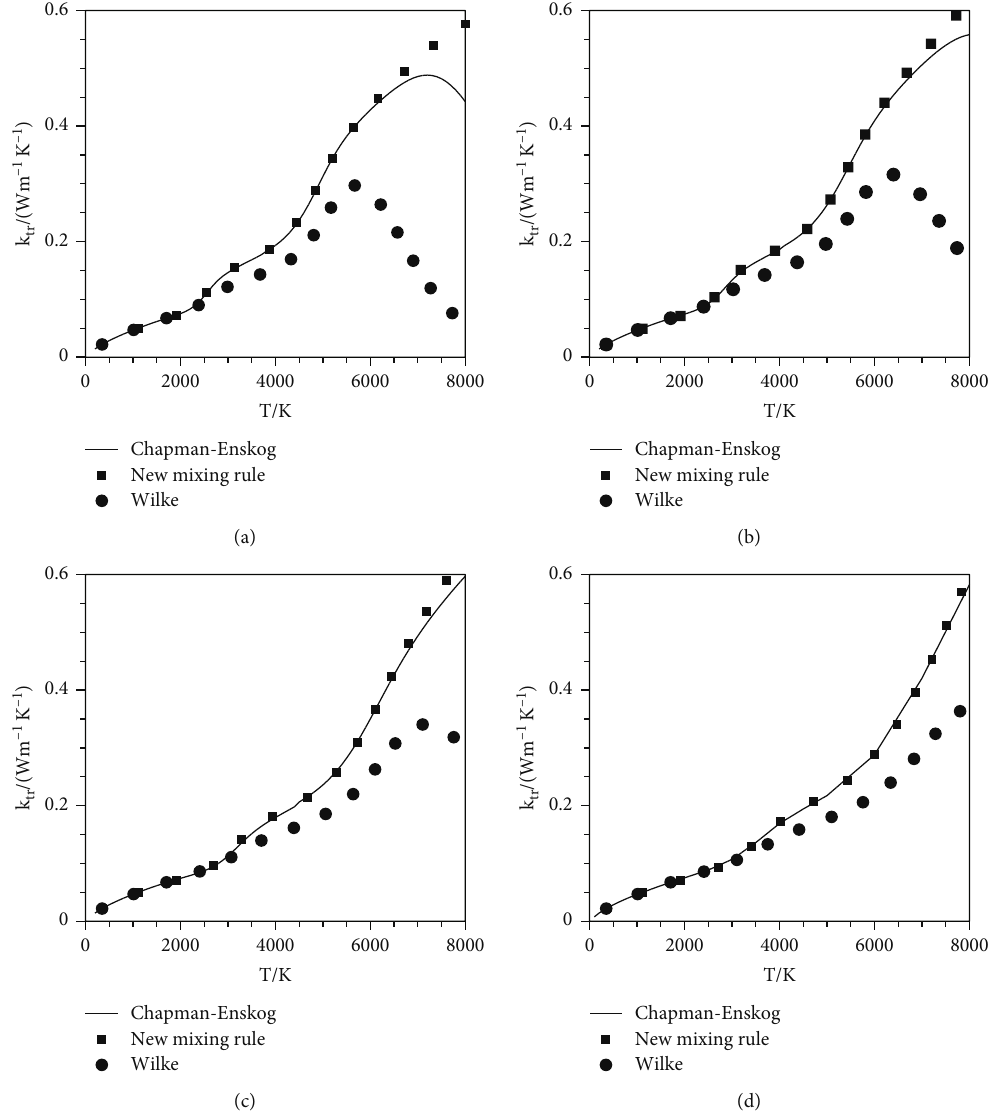
Figure 14: Translational thermal conductivity coe ffi cients by di ff erent methods. (a) 0.001atm, (b) 0.01atm, (c) 0.1atm, and (d) 1